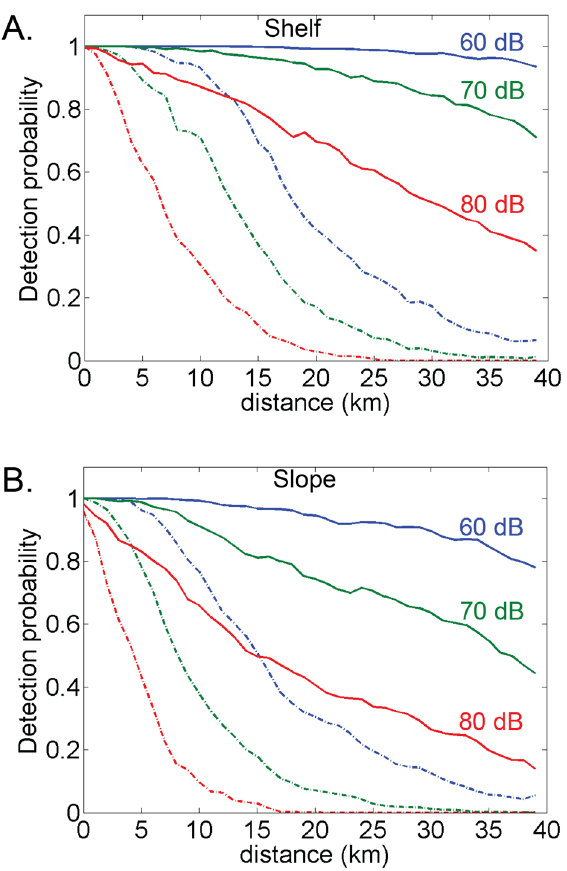
Figure 6. Detection probability as a function of distance for ( A ) shelf and ( B ) slope sites at ambient sound pressure level 60, 70, and 80 dB re 1 μPa 2 (blue, green, and red lines) with open-water (solid line) and ice- covered (dashed line)